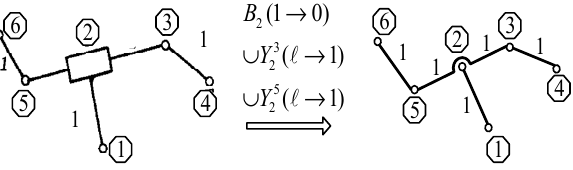
→ → → T Figure 2. Inversion operation. (3) Duplication operation The duplication operation is used to increase or decrease the kinematic size → Y Figure 3. Duplication operation. 3. Configuration Synthesis Method of the Metamorphic Mechanism The basic idea of configuration synthesis of the metamorphic mechanism is illus- trated as follows: (1) the acquirement of the division scheme of each metamorphic element